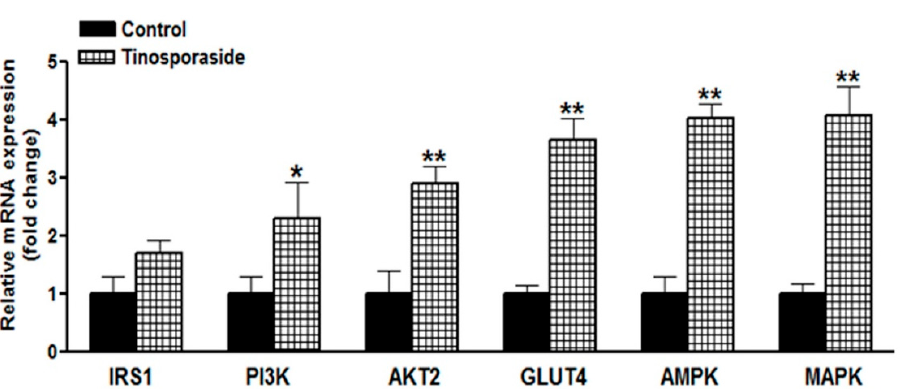
Figure 7. Effect of tinosporaside on gene expression of diabetes-related genes in muscle tissues of C57BL-Ks db/db mice. Skeletal muscle tissues were excised, RNA was isolated from the control and tinosporaside-treated mice, which was followed by real-time PCR for determination of the expression profiling of the indicated genes. Results are expressed as the mean ± SE, n = 3. * p < 0.05, ** p < 0.01, relative to control group.